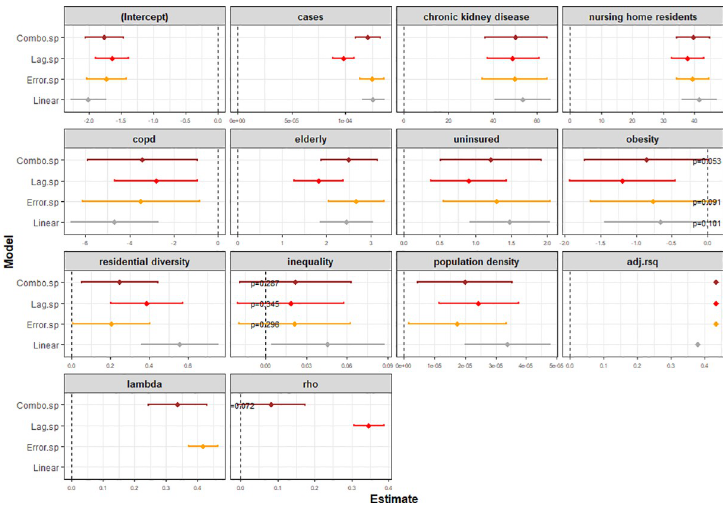
Fig 6. Variables estimates with linear and 3 spatial regression models. p -values indicated when p > 0.05. adj . rsq : adjusted R 2 ; lambda and rho denote the spatial error and spatial lag coefficients,